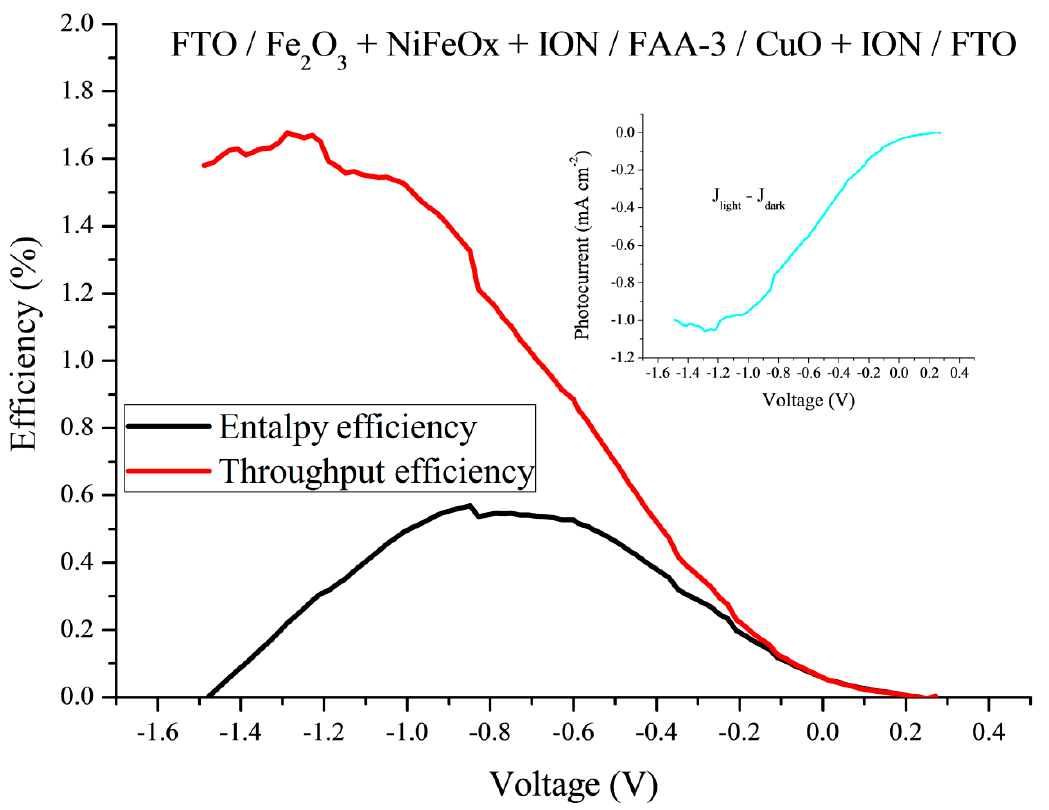
Figure 5. Enthalpy and throughput efficiency of the most performing PEC based on the NiFeOx co-catalyst; polarization behavior of the cell up to − 1.5 V in the inset of the figure.